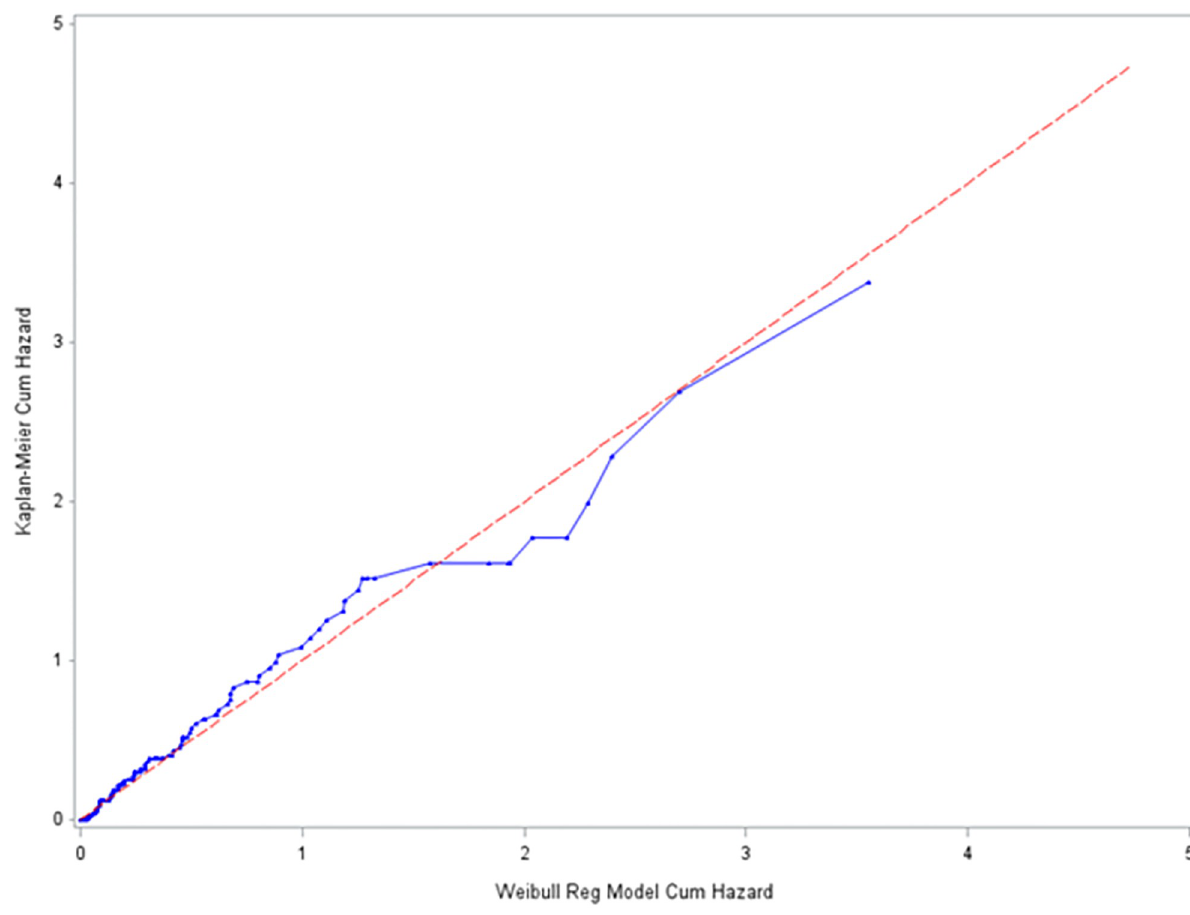
Fig 7. Estimated cumulative hazard plot of the Cox-Snell residuals for the Weibull baseline distribution, LPAC, 2015–2019.